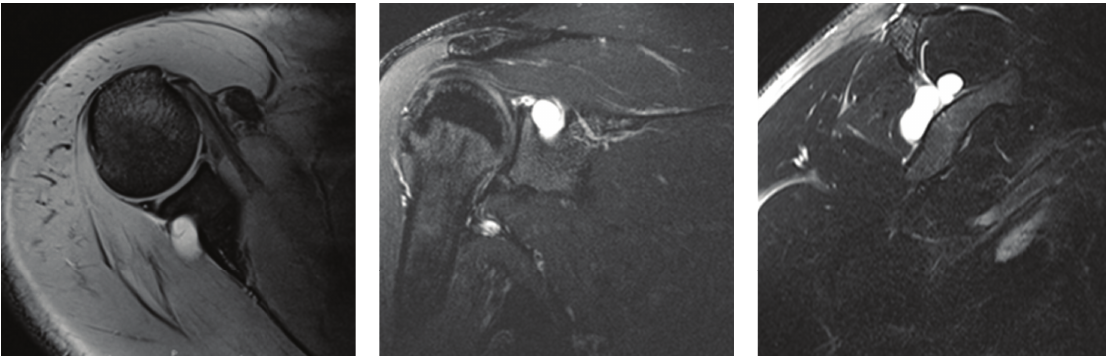
Figure 4: Axial, coronal, and sagittal MRI images of a patient with multiple paralabral cysts in the suprascapular notch and spinoglenoid